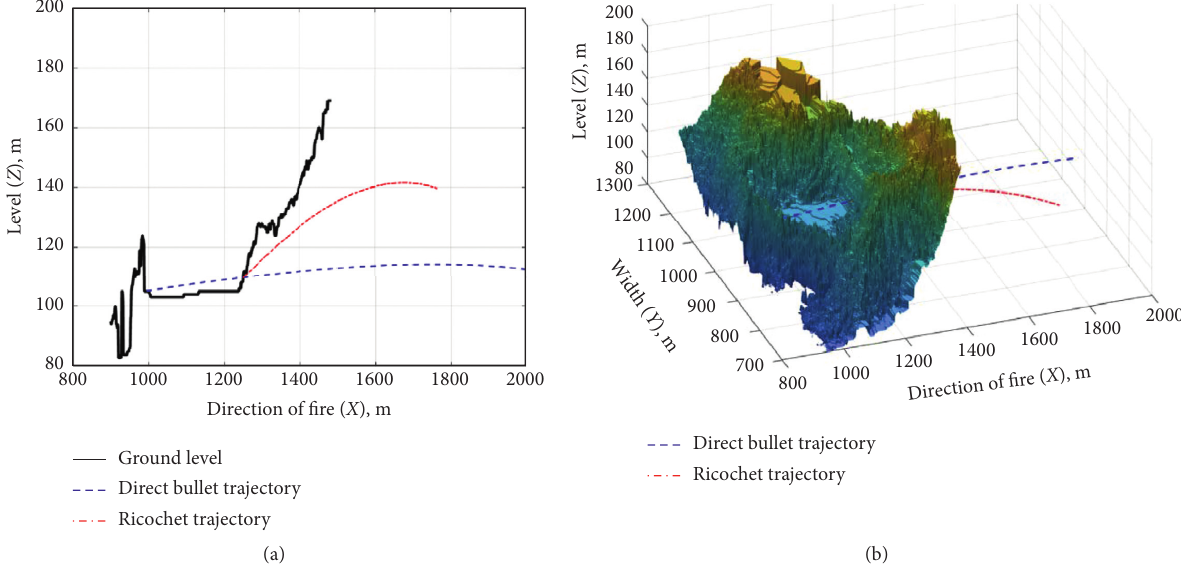
Figure 8: Bullet trajectory curves with topographic data (one fire of K2 rifle and K100 bullet without error). (a) 2D section and (b) 3D topology. Table 3: Initial conditions and input values for calculation of direct bullet